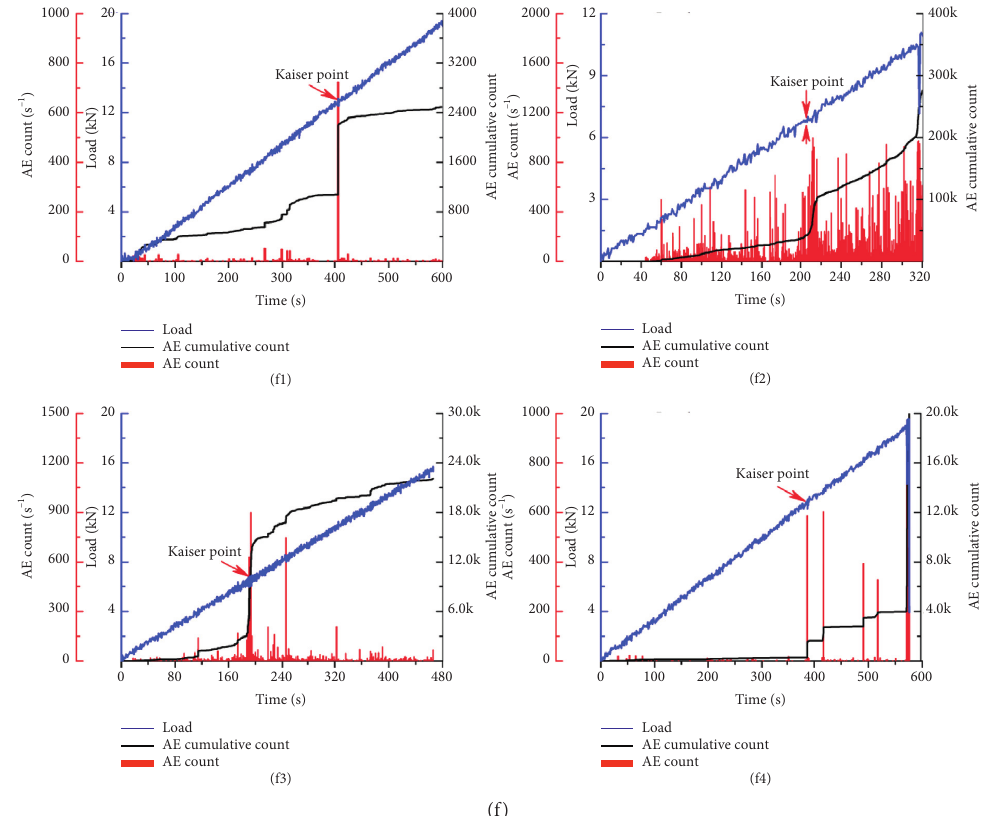
Figure 6: Representative Kaiser point results at each test depth. (a1) Horizontal 0 ° at 200m depth, (a2) horizontal 45 ° at 200m depth, (a3) horizontal 90 ° at 200m depth, (a4) vertical direction at 200m depth, (b1) horizontal 0 ° at 400m depth, (b2) horizontal 45 ° at 400m depth, (b3) horizontal 90 ° at 400m depth, (b4) vertical direction at 400m depth, (c1) horizontal 0 ° at 600 m depth, (c2) horizontal 45 ° at 600m depth, (c3) horizontal 90 ° at 600m depth, (c4) vertical direction at 600m depth, (d1) horizontal 0 ° at 800m depth, (d2) horizontal 45 ° at 800m depth, (d3) horizontal 90 ° at 800m depth, (d4) vertical direction at 800m depth, (e1) horizontal 0 ° at 900m depth, (e2) horizontal 45 ° at 900m depth, (e3) horizontal 90 ° at 900m depth, (e4) vertical direction at 900m depth, (f1) horizontal 0 ° at 1000m depth, (f2) horizontal 45 ° at 1000m depth, (f3) horizontal 90 ° at 1000m depth, and (f4) vertical direction at 1000m